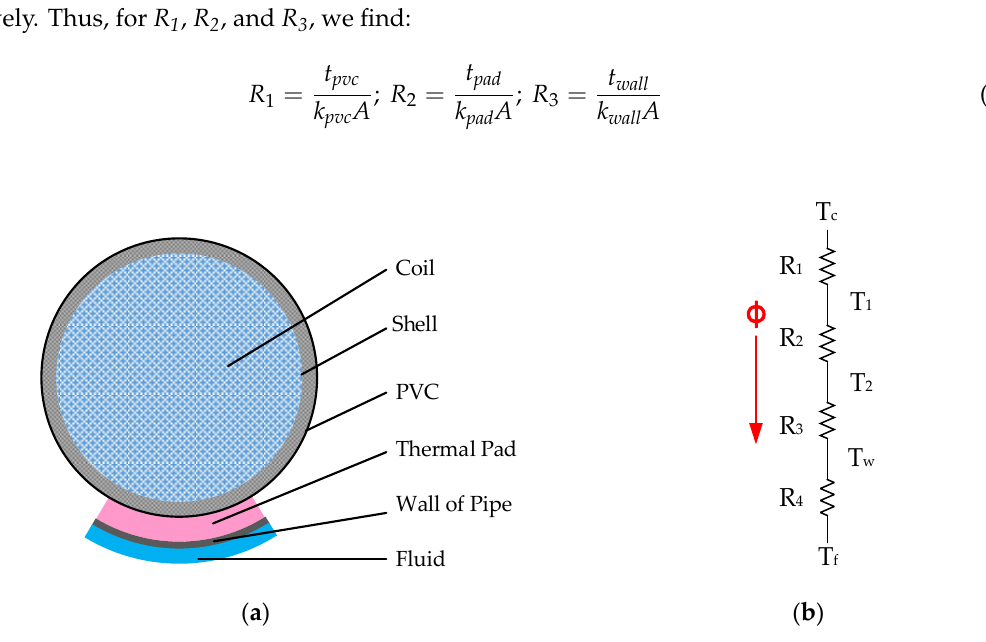
Figure 4. A single cell heat transfer model. ( a ) Schematic of the heat transfer pass of a single cell ( b ) presented as heat resistance.